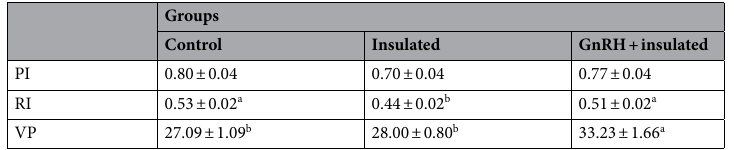
Table 5. The effect of insulation (with and without GnRH injection) and time on PI and RI in bucks. a,b,c Means with different small superscript letters in the same row are significantly different ( p < 0.05) (Duncan test).